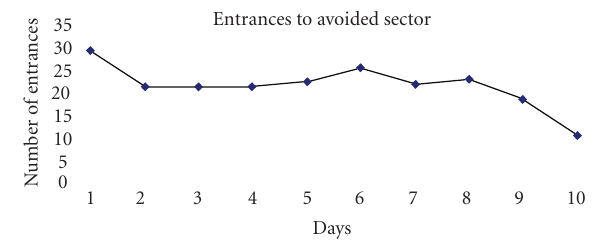
Figure 1: Number of entrances to avoided sector during ten exper- imental days. The main di ff erences are between 1-th a 2-th days and between 10-th and first days, when character of moving arena had changed.